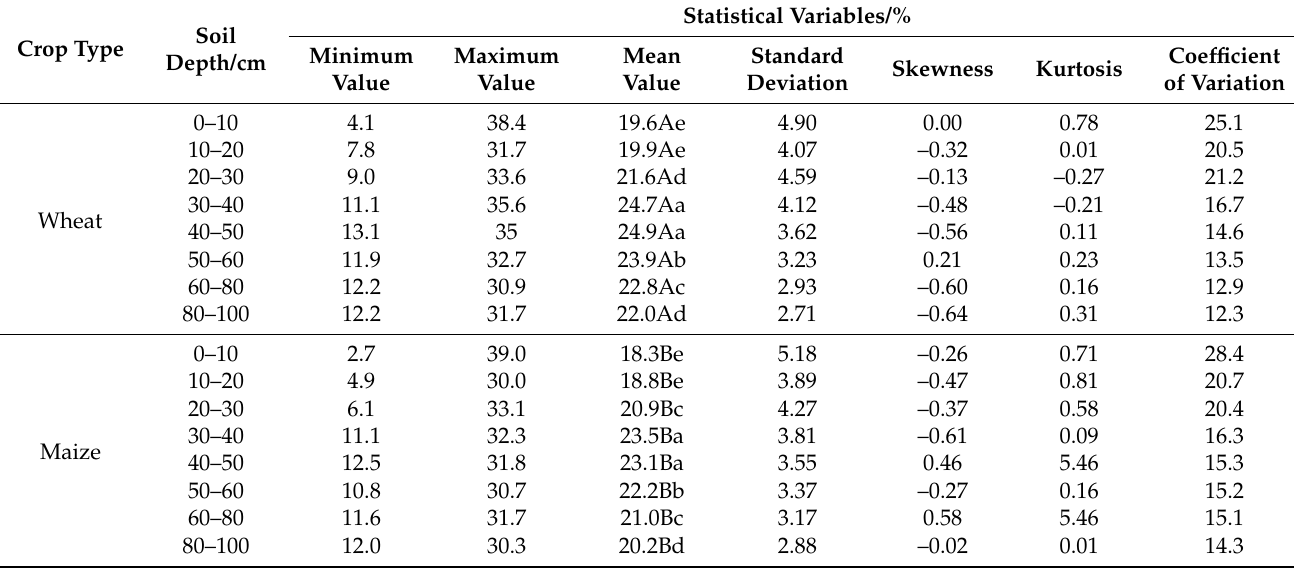
Table 3. Statistical characteristics of soil moisture content of different crops.